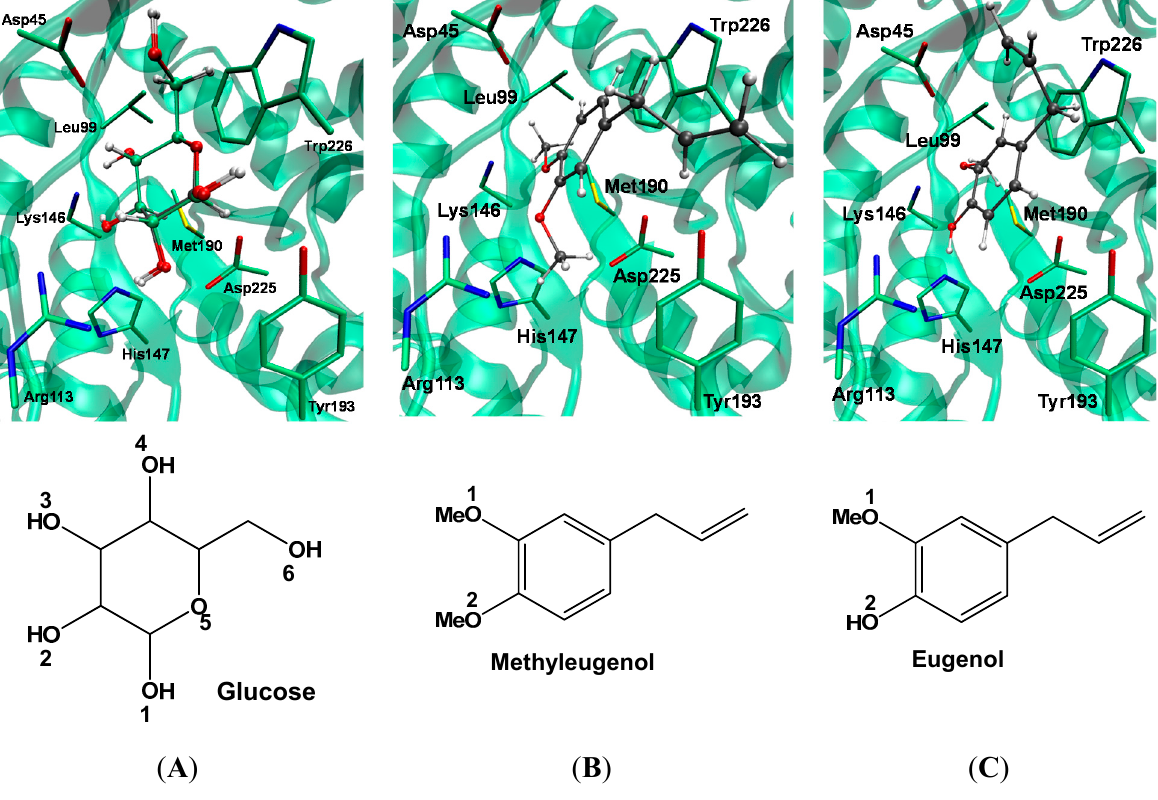
Figure 5. Re-docking conformational results for natural substrates: glucose ( A ); methyleugenol ( B ) and eugenol ( C ). The crystal reference is in gray carbon atoms, and theoretical result is in green carbon atoms. The residues are shown in tube model and the ligands in CPK model. The conformational results were obtained by molecular docking using MVD software.